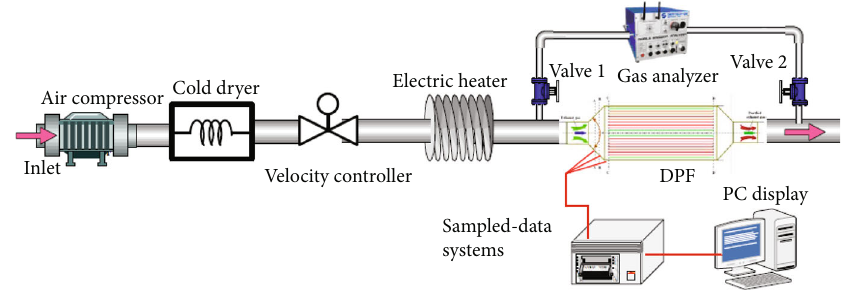
Figure 3: Schematic diagram of experimental equipment.